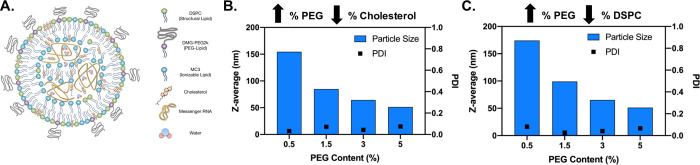
LNP characterization.(A) Schematic of an LNP listing all major components. (B) Bar graph showing the size and PDI of one set of particles when percentage of PEG is increased and modulated against cholesterol. (C) Bar graph showing size and PDI of one set of particles when percentage of PEG is increased and modulated against DSPC. DSPC-1,2-distearoyl-sn-glycero-3-phosphocholine, DMG-PEG2k-1,2-dimyristoyl-rac-glycero-3-methoxypolyethylene glycol-2000, MC3-Dlin-MC3-DMA, PDI-polydispersity index.